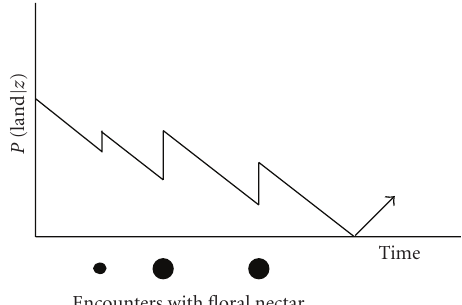
Figure 2: A graphical interpretation of the increment-decay model for bumble bee patch departure. The conditional probability of landing on the next flower given the weighted stimuli sum z , P (Land | z ), is plotted as a function of time. The probability declines monotonically with time. If the bee finds nectar within a flower, the probability increases in proportion to the nectar volume. Solid circles represent reception of nectar, with the radius proportional to the nectar volume. Note that for the same amount of nectar the amount of incrementing is less in sequence, following (4) in the text. When the threshold z ∗ reaches its maximum value, it then spontaneously decreases, increasing the landing probability during interpatch travel